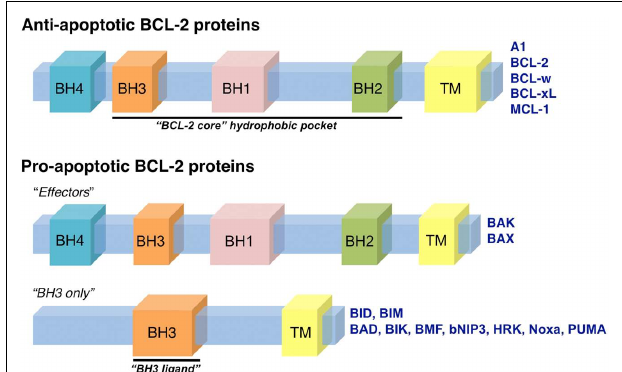
FIGURE 2 |The BCL-2 family of proteins. The BCL-2 family of proteins is divided into anti-apoptotic and pro-apoptotic members.The anti-apoptotic members include: A1, BCL-2, BCL-w, BCL-xL, and MCL-1, all of which contain four BCL-2 homology domains (termed BH1-4).The pro-apoptotic proteins are subdivided into “effector” and “BH3-only” members.The effector proteins, BAK and BAX, also contain BH1-4; while the BH3-only proteins contain only one domain, a BH3, that is required for interactions with anti-apoptotic and effector proteins.The BH3-only proteins include: BAD, BID, BIK, BIM, BMF, bNIP3, HRK, Noxa, and PUMA.The BH1-3 regions form the conserved “BCL-2 core” structural unit, which includes a hydrophobic groove that binds to BH3 domains. Many of the BCL-2 family proteins also contain a transmembrane domain